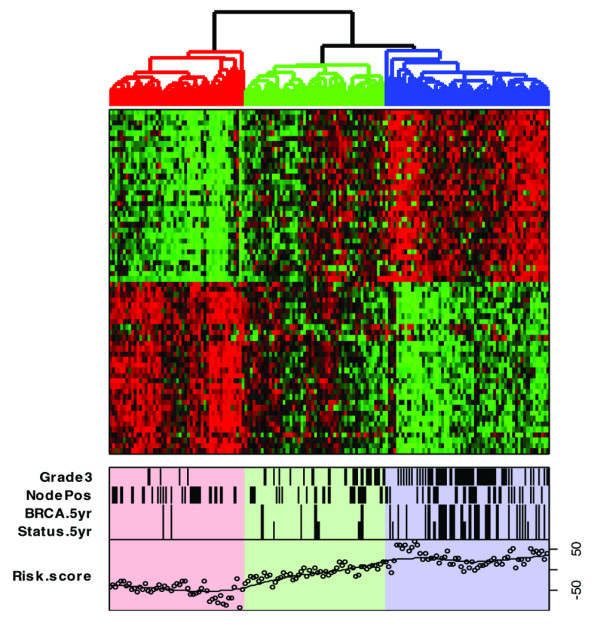
Unsupervised hierarchical clustering of the Stockholm cohort (n = 159) using the 64-gene set. Each column refers to a patient and each row to a gene. Red indicates a high value of gene expression, and green indicates a low value. The list of genes is presented in Additional file 1, in the same order as they appear on the plot. Risk.score, computed by linear discriminant analysis and used here only to describe the clusters. Status.5 yr, black if the corresponding patient had distant metastasis or died within 5 years. BRCA.5 yr, black if the death was due to breast cancer. NodePos, black if the corresponding patient was lymph-node-positive; Grade3, black if the patient had Elston grade 3.